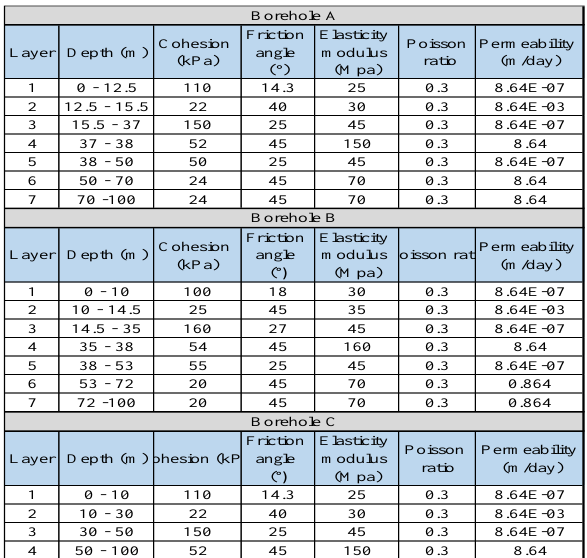
Table 1. Geotechnical information at selected points (A, B, C)